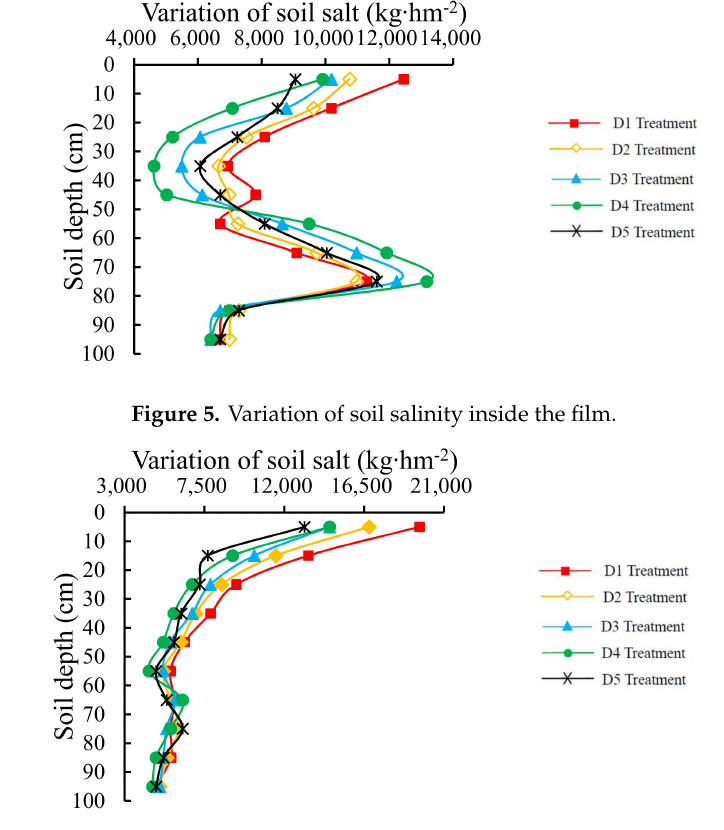
Figure 6. Variation of soil salinity outside the